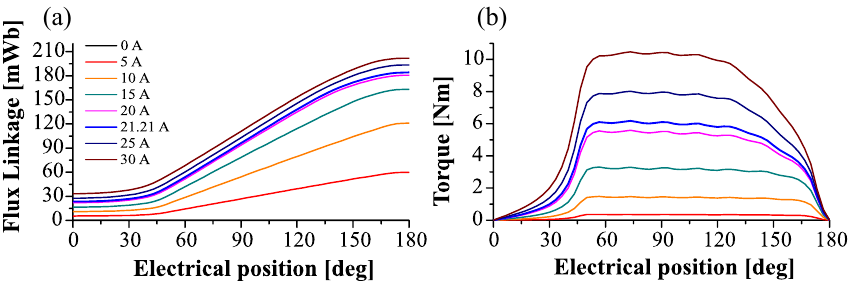
Figure 10. Static electromagnetic characteristics of the 8/6 SRM: ( a ) flux linkage and ( b )